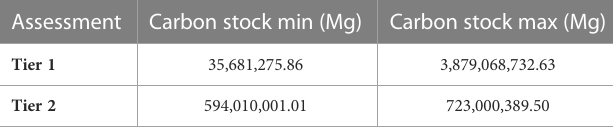
TABLE 1 Tier 1 and 2 carbon stocks for the classi fi ed minimum and maximum seagrass ecosystem